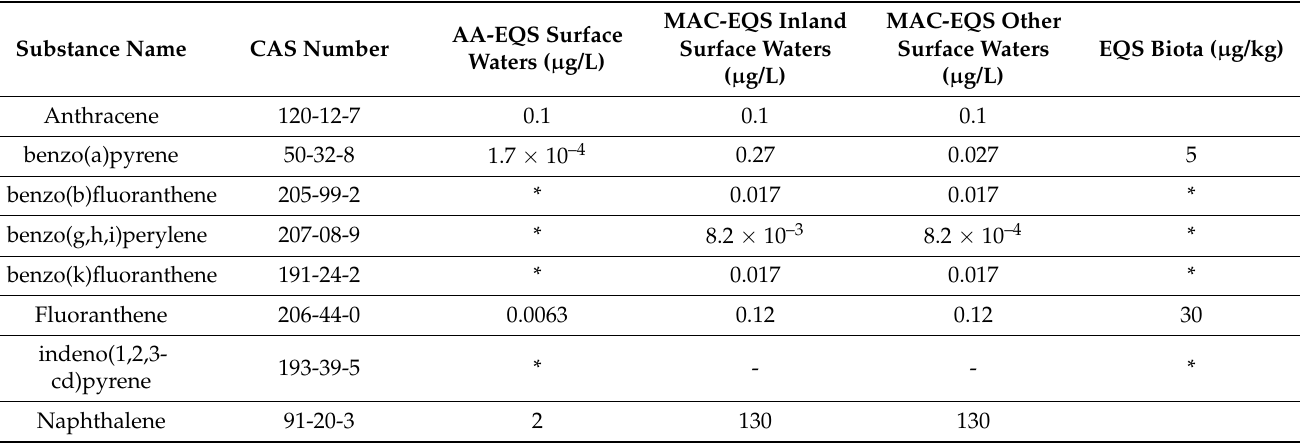
Table 1. Environmental quality standards (EQS) for PAHs. AA = annual average, MAC = maximum average concentration (2013/39/EU